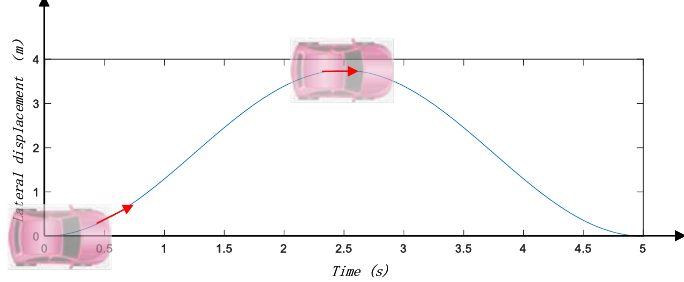
Figure 3. Diagram of a cosine lane change